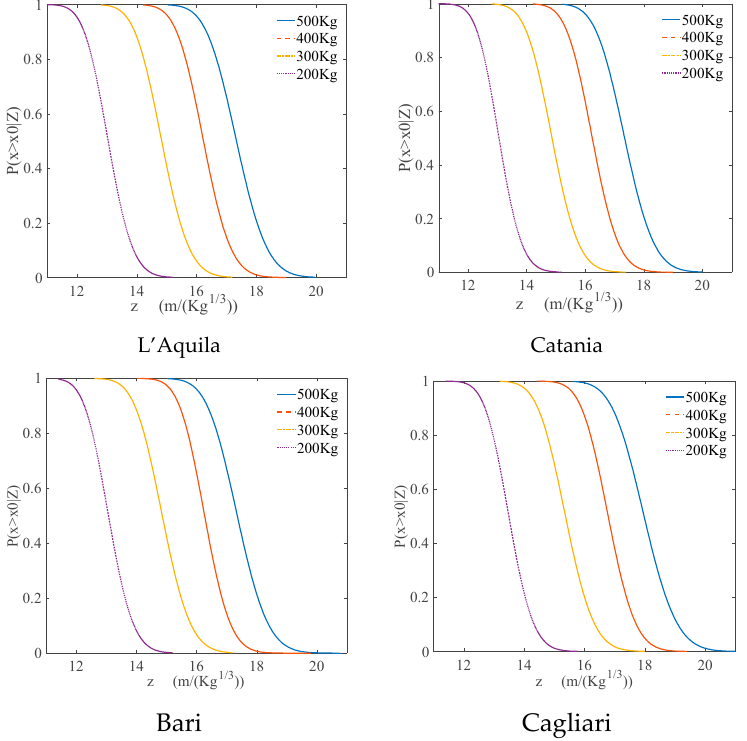
Bari Figure 10. Fragility curves for slight damage condition for each structure location. Figure 10. Fragility curves for slight damage condition for each structure